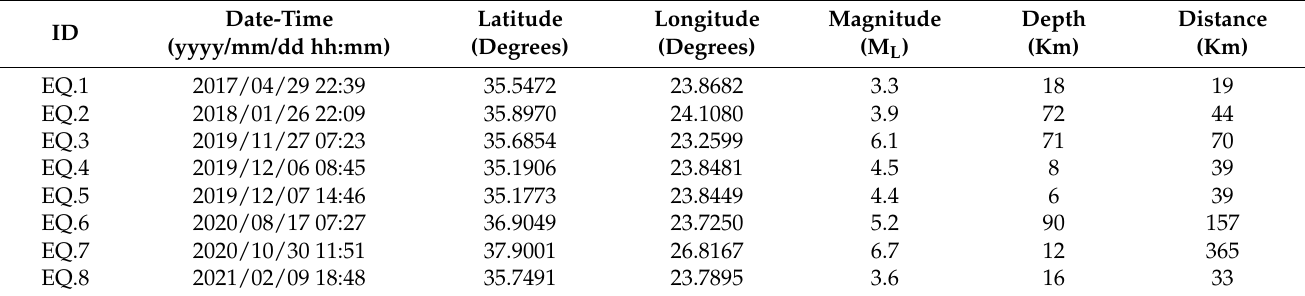
Table 2. The earthquake parameters obtained from NOA and the distance form